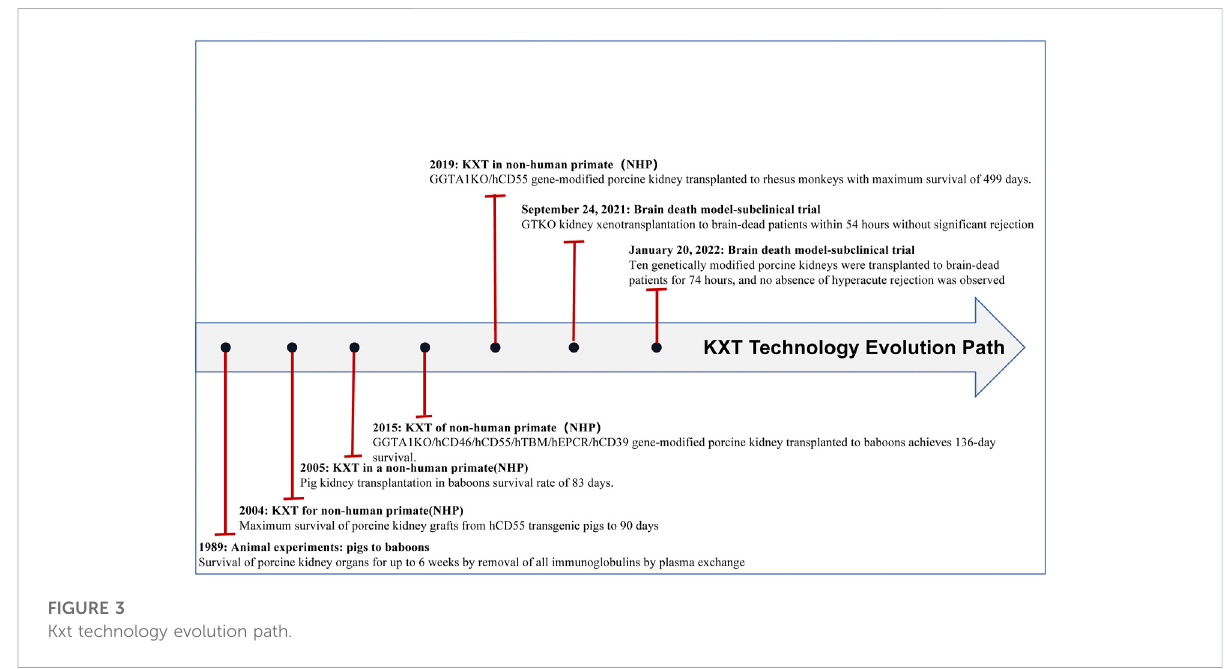
FIGURE 3 Kxt technology evolution path.